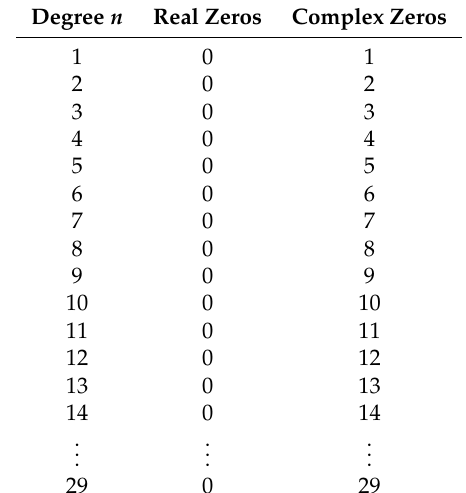
Table 2. Numbers of real and complex zeros of H n ( x ,2 ) .